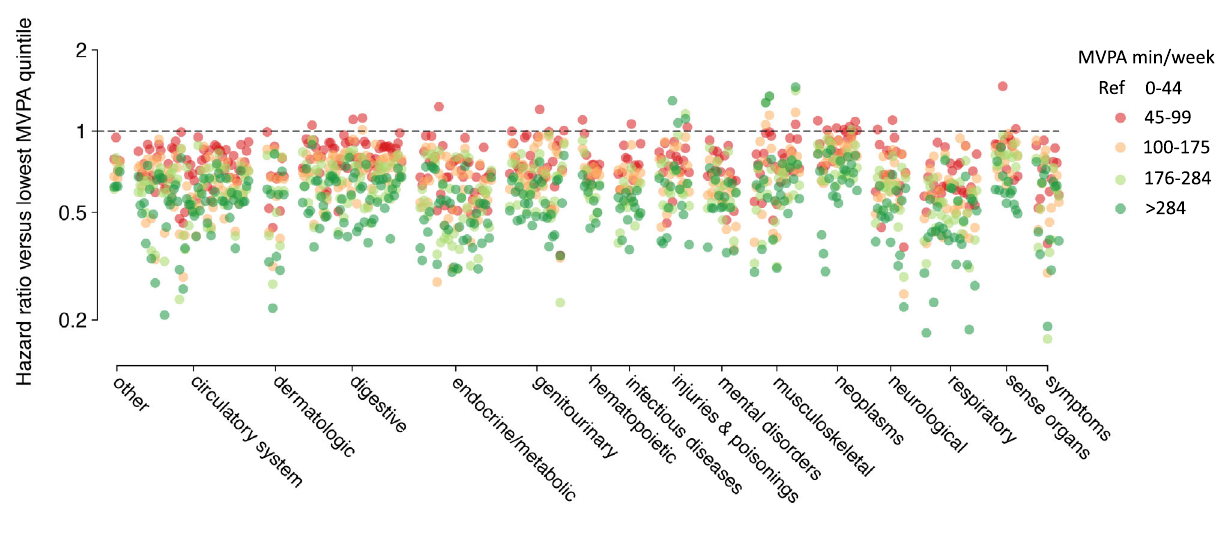
Fig. 4 Associations between quintile of measured MVPA and incident disease. Depicted is the relative hazard of incident disease according to quintile of accelerometer-measured moderate-to-vigorous physical activity (MVPA) and grouped by disease category. Each disease is represented by four points, with each point representing the hazard ratio associated with a given quintile of MVPA (quintile 2 = red, quintile 3 = orange, quintile 4 = light green, quintile 5 = dark green), as compared to the lowest quintile (quintile 1) as the referent. MVPA volumes corresponding to each quintile are shown in the legend. The hashed horizontal line depicts a hazard ratio of one (i.e., equal hazard to quintile 1). A single value below 0.1 was rounded to 0.1 for graphical purposes (bottom